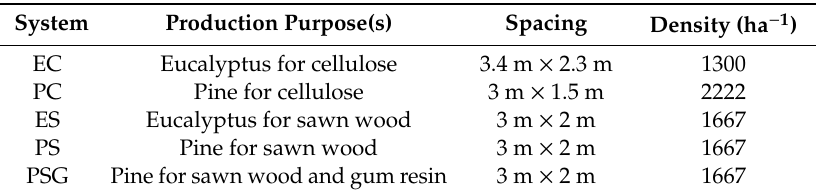
Table 1. Description of production systems.